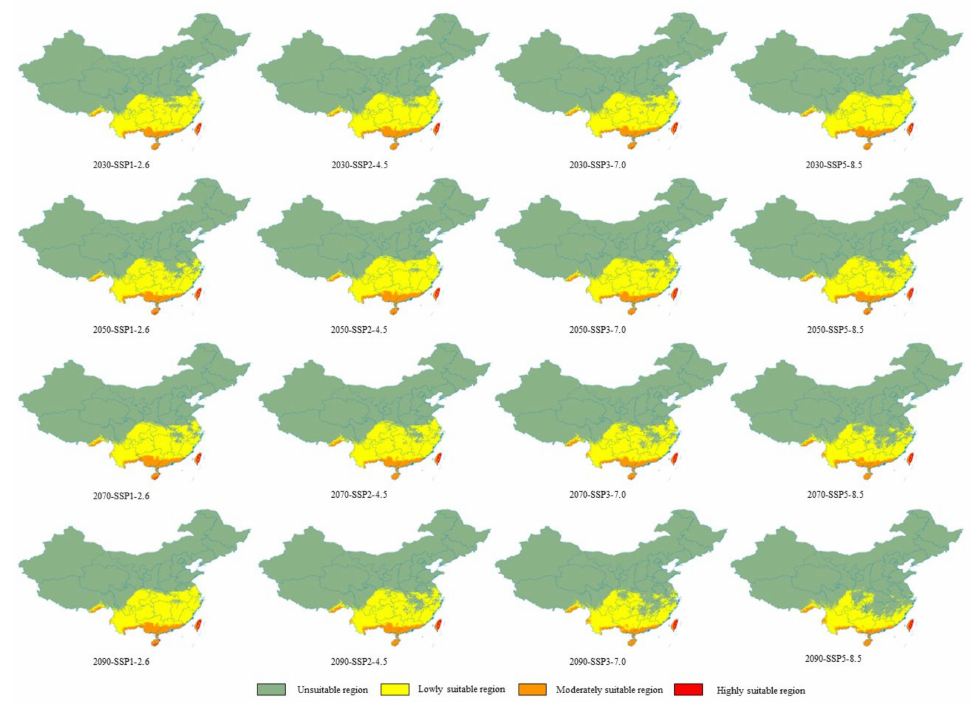
Figure 7. Maps of the W. auropunctata distribution in different climate scenarios and periods (2030s, 2050s, 2070s, and 2090s) of the 21st century. The shared socioeconomic pathways (SSPs) 1–2.6, SSP2–4.5, SSP3–7.0, and SSP5–8.5 represent four climate